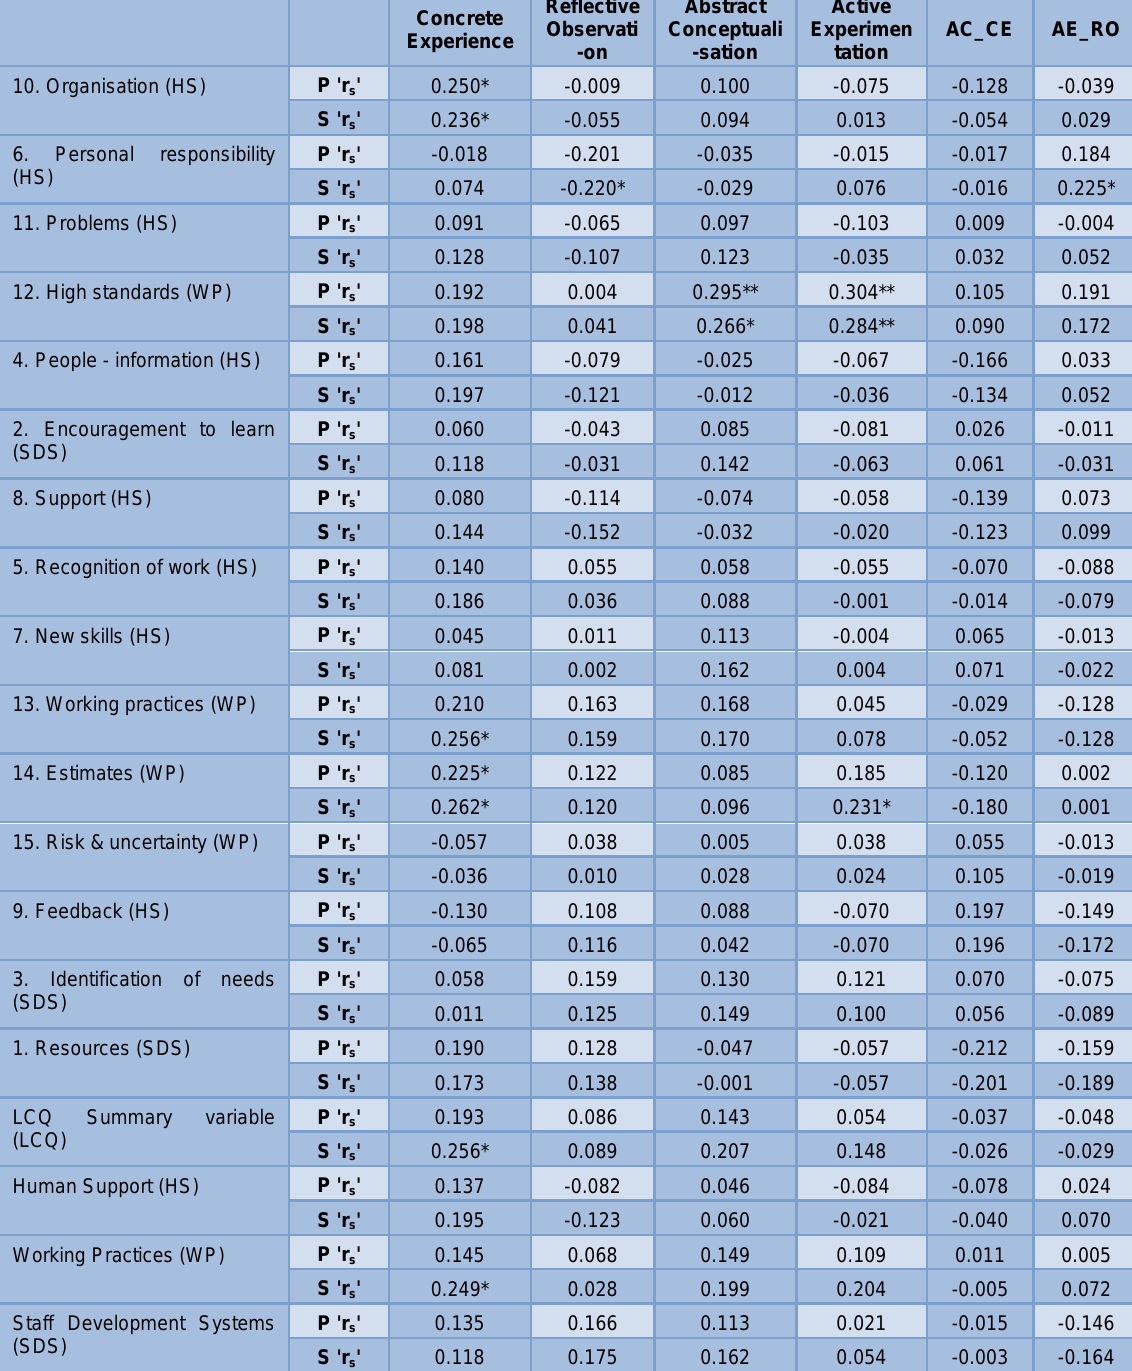
Table 7 Correlations between Learning Climate Questions and Kolb's Learning Style Inventory - 1985 revised subscales (n =